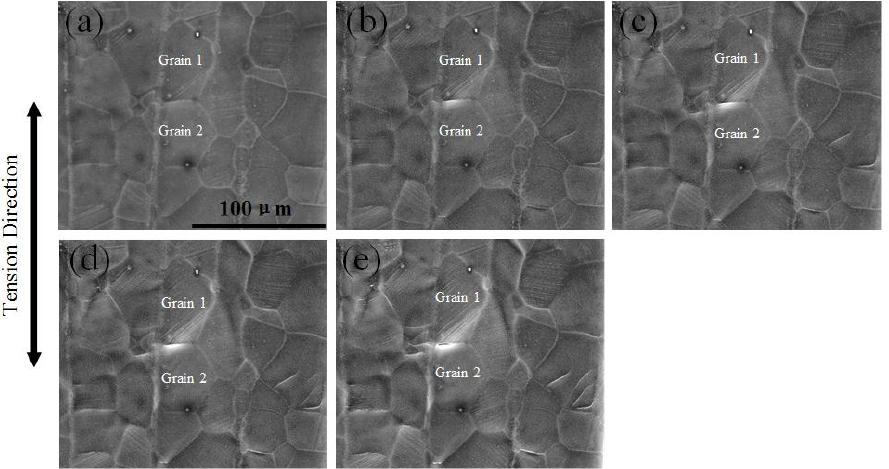
Figure 2. Microstructure during in situ tension test at strain of ( a ) 9.5%, ( b ) 11.5%, ( c ) 12.5%, ( d ) 13.5%, ( e ) 15.5%.